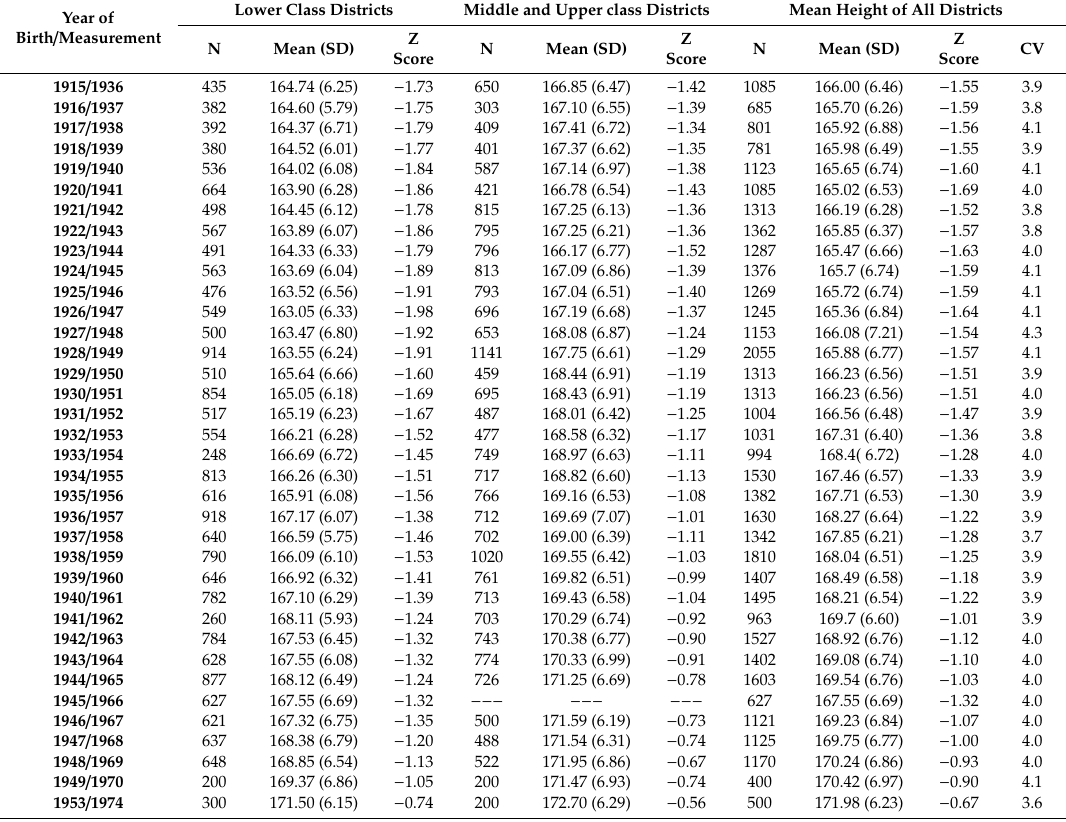
Table 2. Mean height and z-score by year in lower, middle, and upper class districts, and total mean height, z-score, and coe ffi cient of variation (CV) (Source: AGMG). Lower Class Districts Middle and Upper class Districts Mean Height of All Year of Birth / Measurement